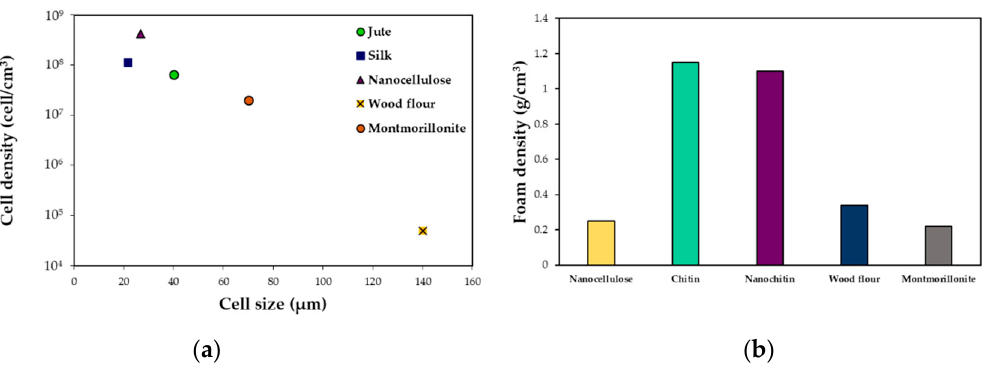
Figure 17. ( a ) Cell density and cell size for different fillers at 5 wt% content in PLA and ( b ) foam density for different fillers between 3 and 5 wt% contents in PLA. Data taken from Zafar t al. [128], Kang et al. [129], Cho et al. [125], Neagu et al. [127], and Ema et al. [131].